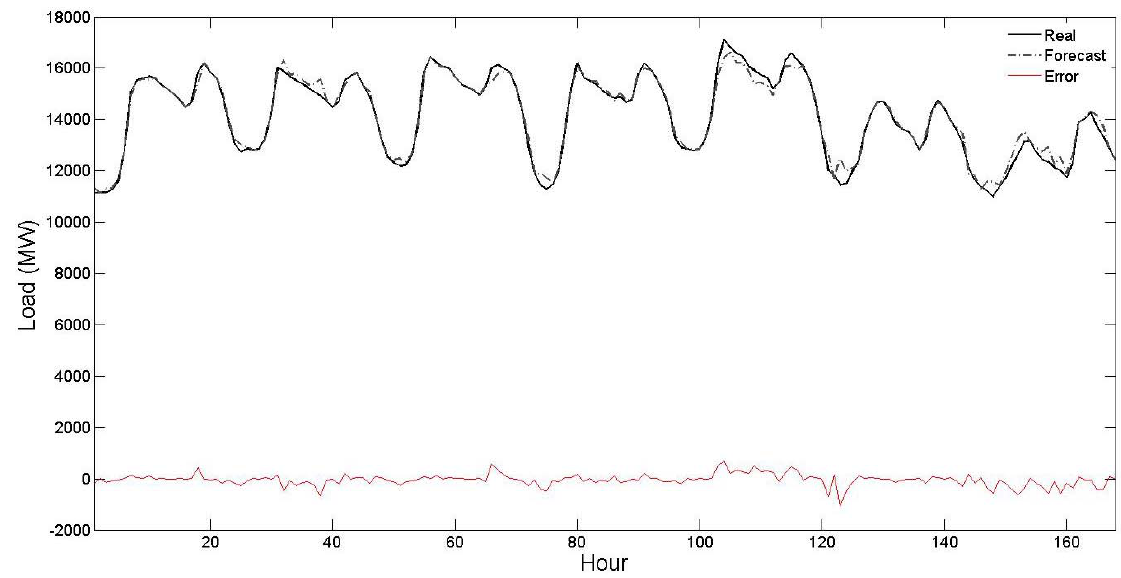
Figure 5. Curves of real values, forecast values and forecast errors for the fourth test week of Table 1 (the forecast results are related to the proposed